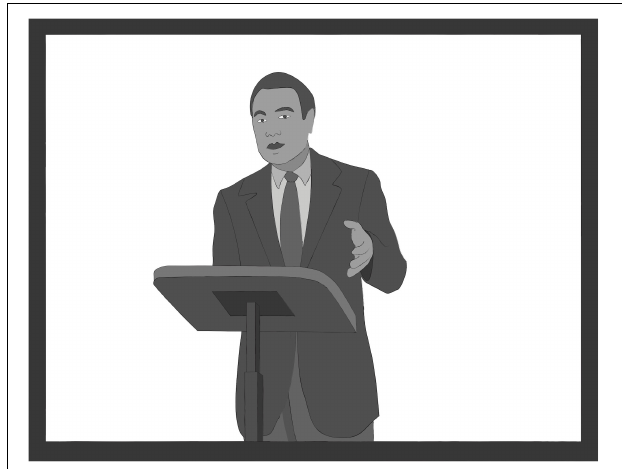
FIGURE 1 | Illustration of the view of the speaker provided by the video samples analyzed in this study. For most of the sample, the speaker’s upper torso is visible, including the full extent of the arms and hands, enabling the annotation of the co-speech gestural movements in 2-dimensional